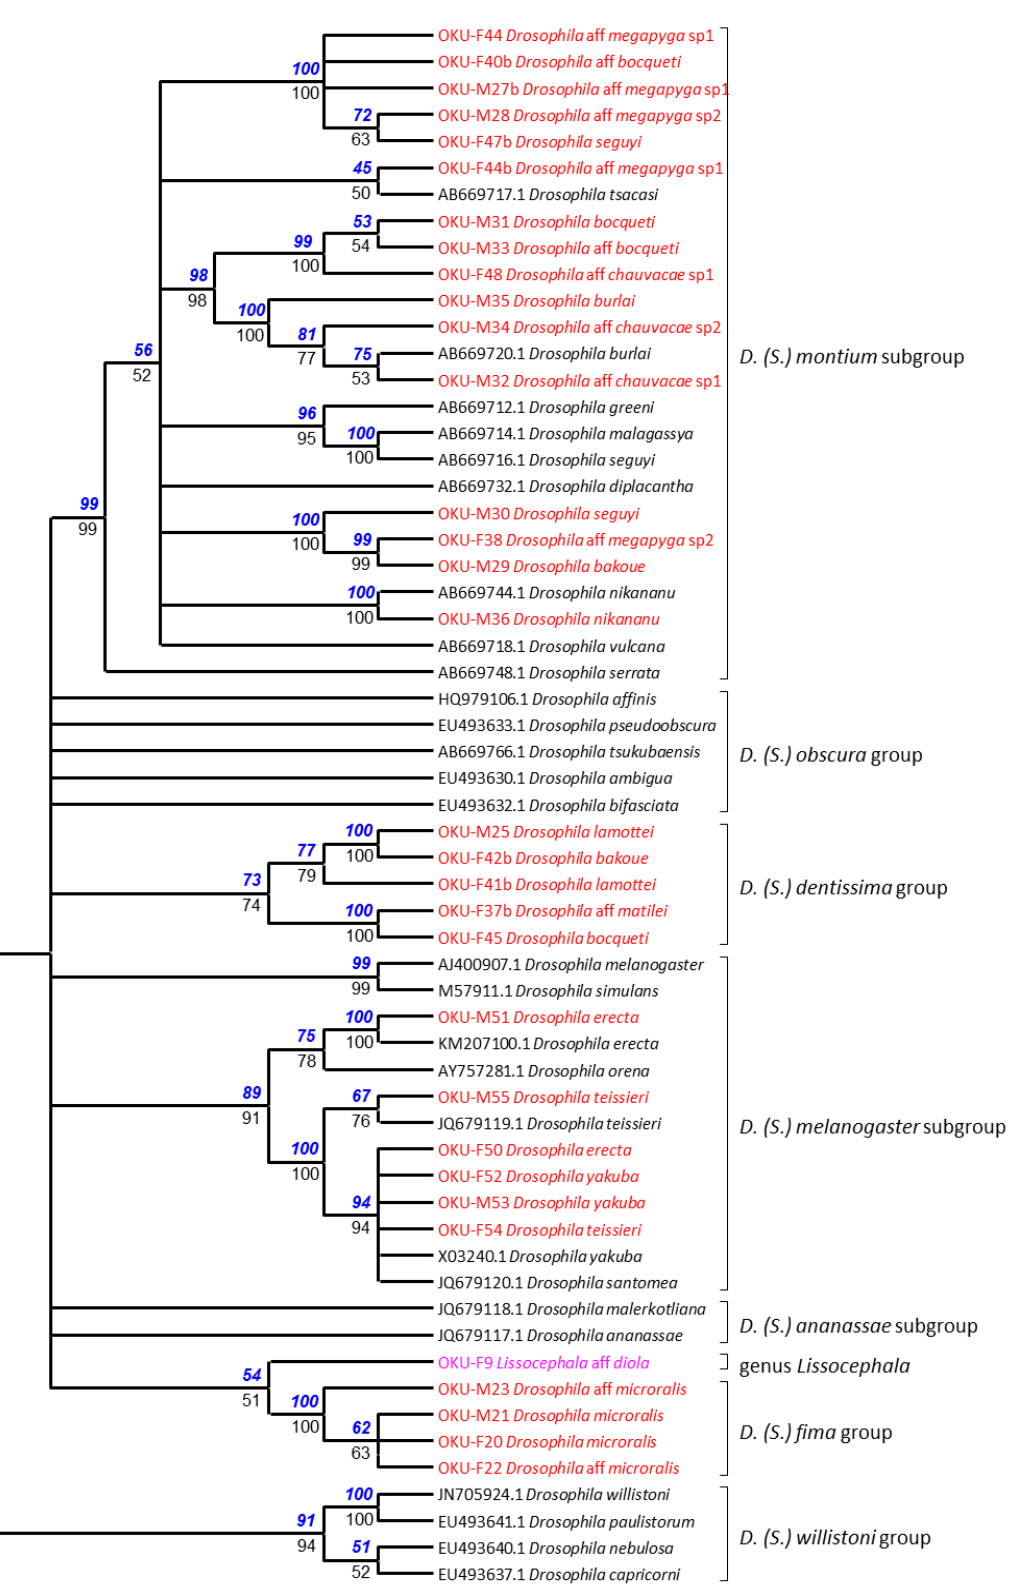
Fig. 4. Phylogenetic analysis of the subgenus Sophophora and Lissocephala aff. diola Tsacas & Lachaise, 1979. Conventions as for Fig.